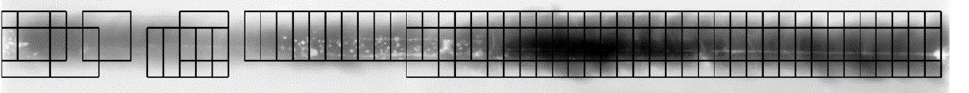
Figure 5. An illustration of overlapping patches that are classified as defects. Each patch is high- lighted using the black color rectangular bounding box.